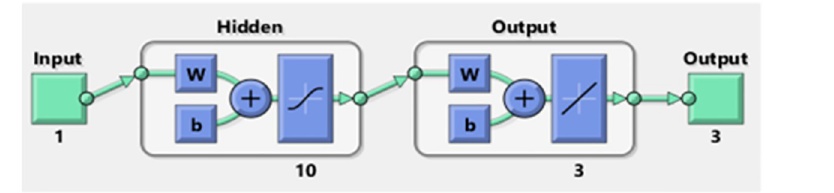
Fig 3. Proposed SCGNNs for solving the infection FONPPS.